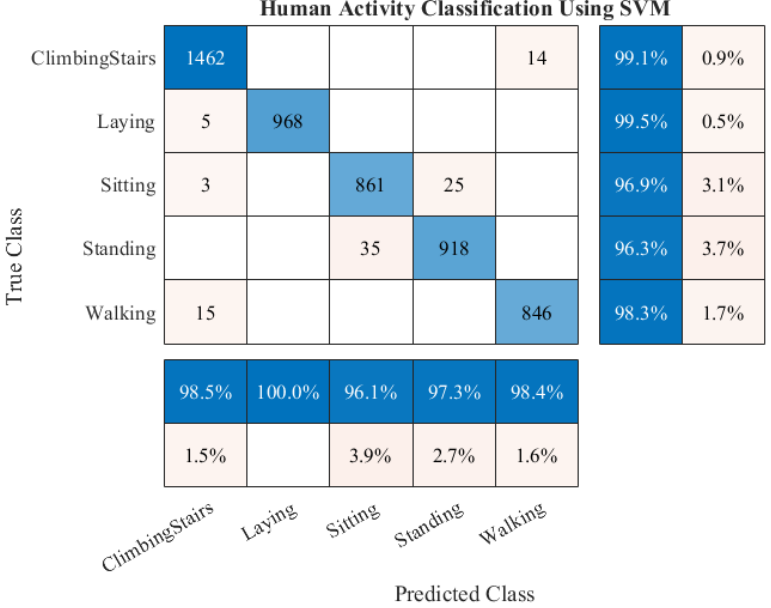
Figure 10. Confusion matrix of the proposed model on UCI-HAR dataset for the five best